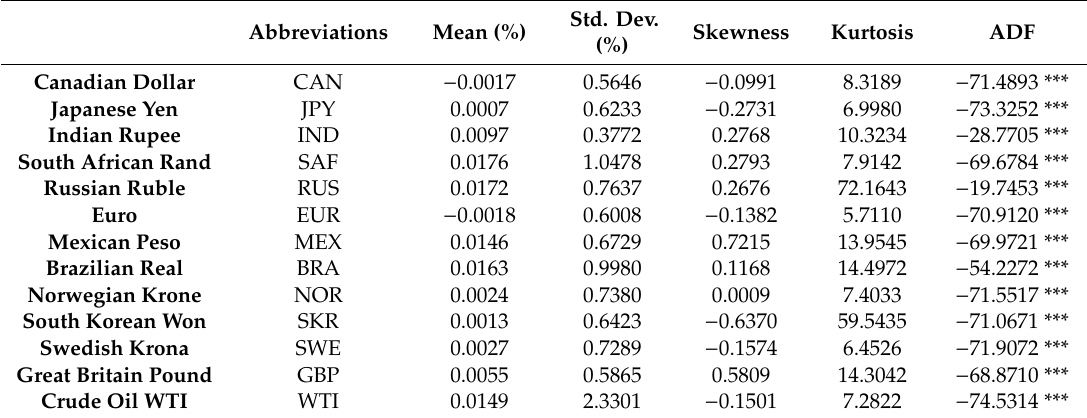
Table 1. Descriptive statistics for sample currencies and crude oil